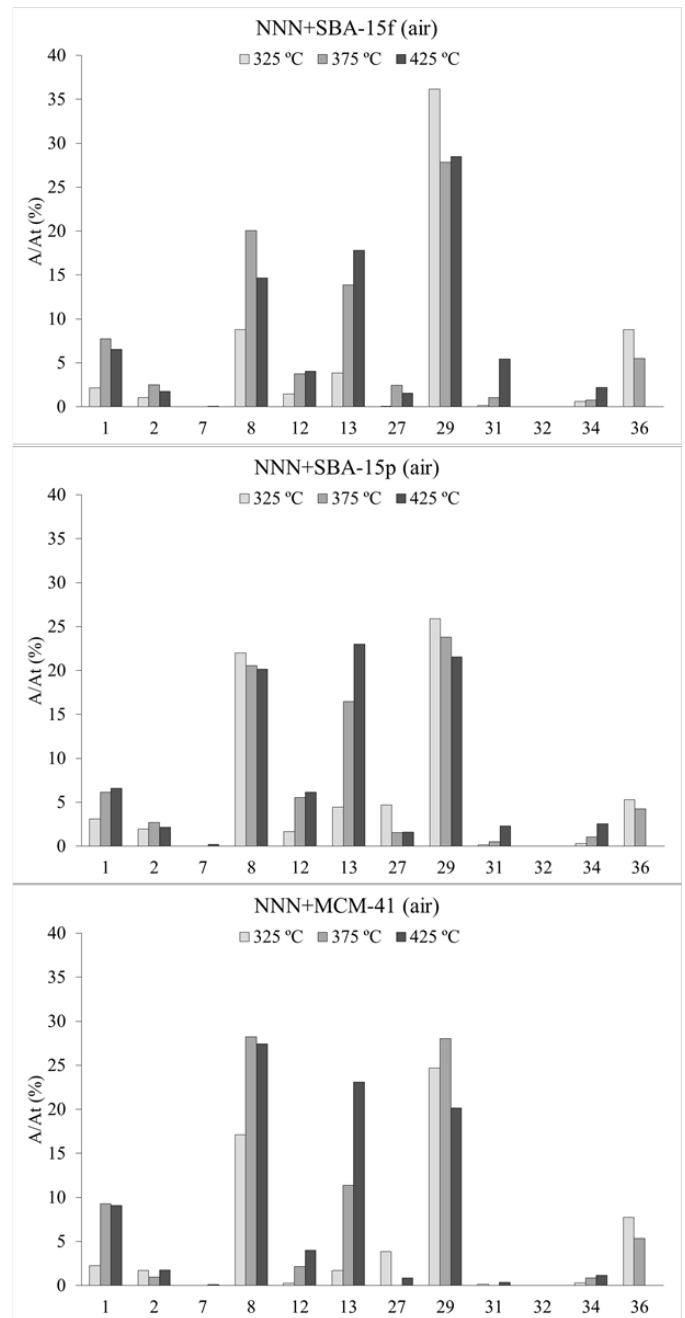
Figure 16. % area vs temperature of the majority compounds detected in the pyrolysis of NNN with three catalysts under air atmosphere. Carbon dioxide (1), nitric oxide (2), formaldehyde (7), water (8), 3-pyridinecarboxaldehyde (12), 3-pyridinecarbonitrile (13), 1H-pyrrolo [2,3-b] pyridine (27), myosmine (29), nicotiryne (31), 4-pyridinecarboxamide (32), nornicotiryne (34) y 5,6-dimethyl-3H-pyrrolo [2,3-b] pyridine (36).